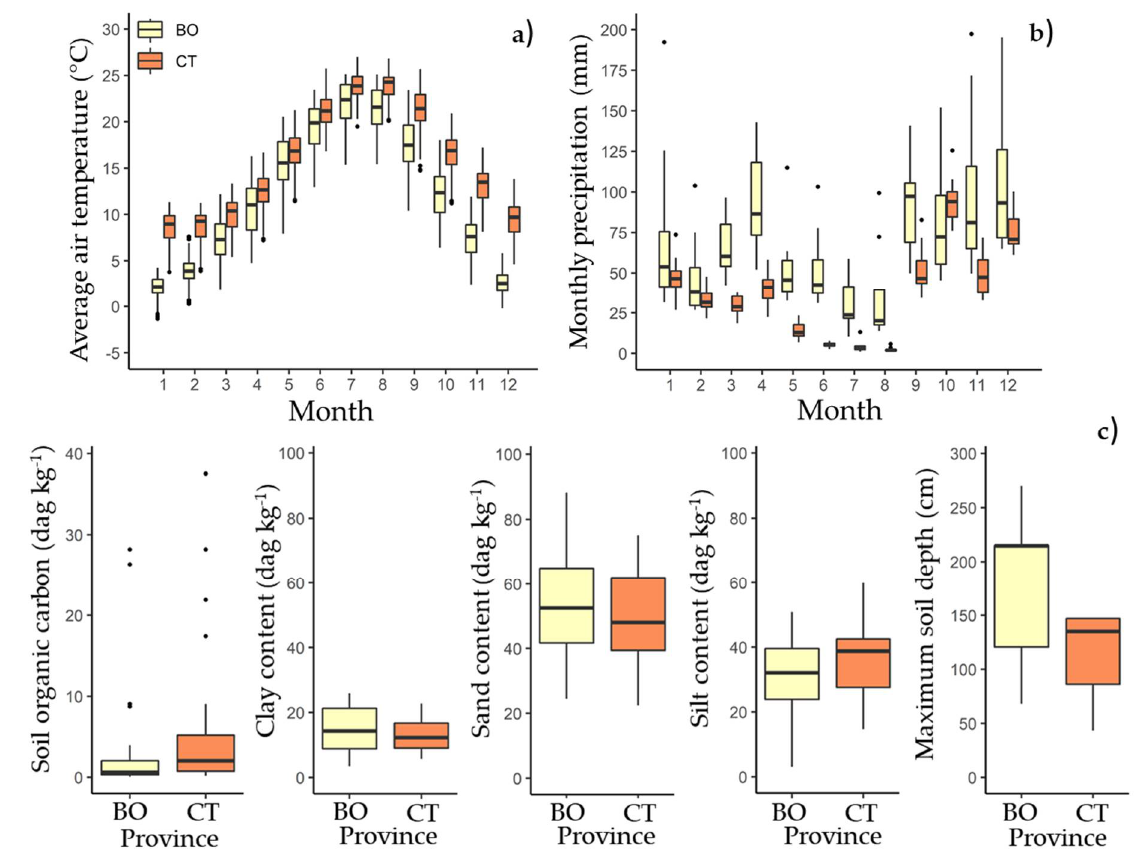
Figure 2. Pedo-climatic characterization of Bologna (BO) and Catania (CT) provinces under current climate conditions. ( a , b ) Mean trends of monthly average air temperature and monthly precipitation during the period 1993–2007 for all the marginal lands (MLs) considered in the spatially distributed simulation experiment (Section 2.3). ( c ) Variability of the main soil characteristics across MLs. Black dots represent outlier values.